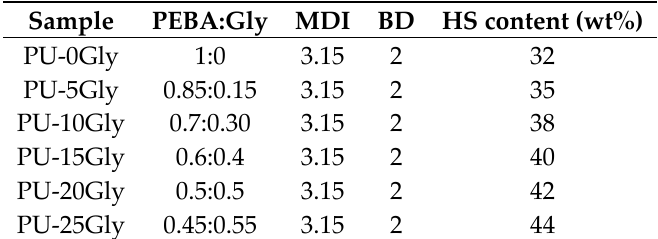
Table 1. Designation, reactants molar ratio and HS content (wt%) of synthesized thermoplastic